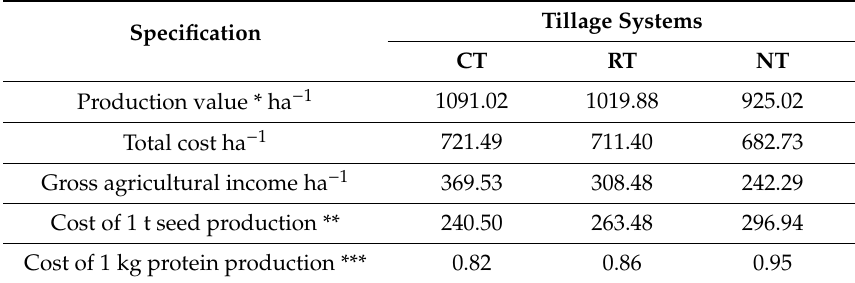
Table 5. Economic analysis of profitability of narrow-leaved lupin (NL) cultivation under di ff erent soil tillage systems (all values expressed in euro).